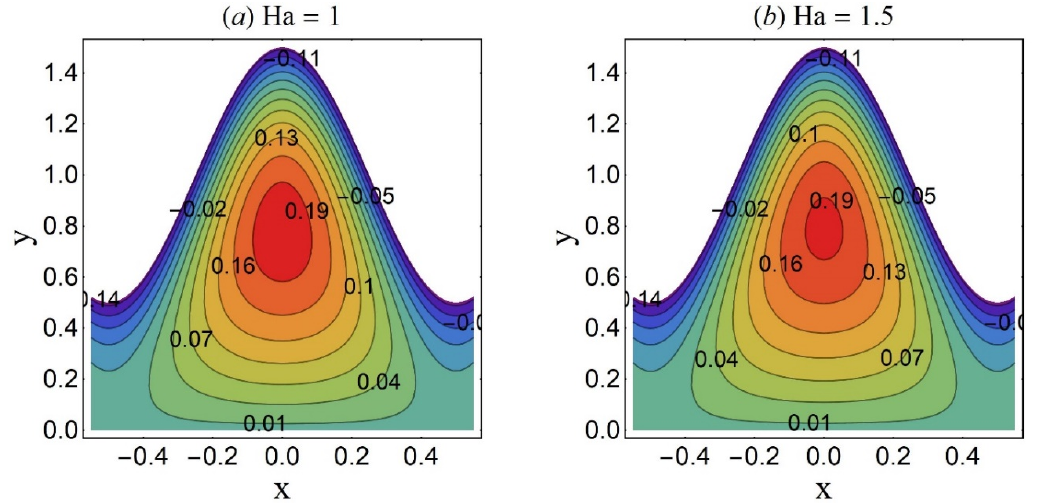
Figure 9. Streamline pattern for ( a ) ε = 0.4 and ( b ) ε = 0.4 at fixed values of Ha = 1 and We = 0.01.